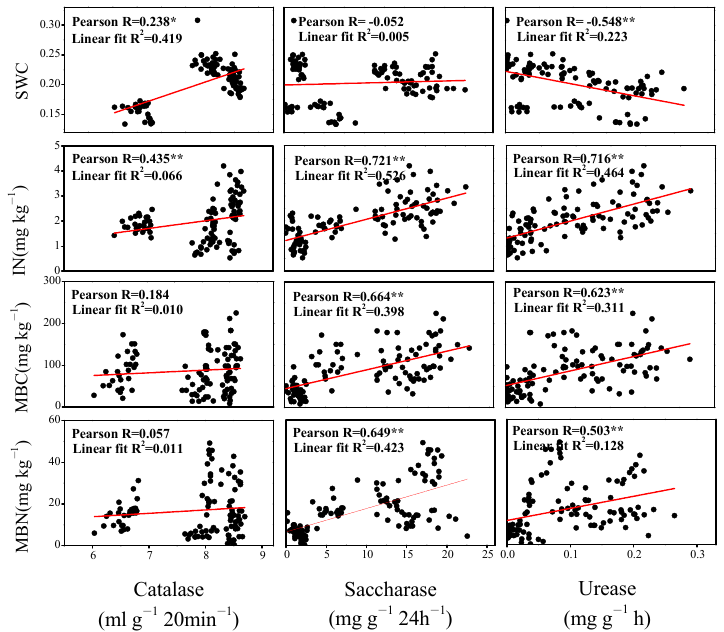
Figure 7. Linear fitting and Pearson correlation coefficients (Pearson’s R) between soil properties and soil enzyme activities in the poplar plantation after pruning treatments. Note: Statistically sig- nificant values are indicated by symbols: ** p < 0.01; * p < 0.05.